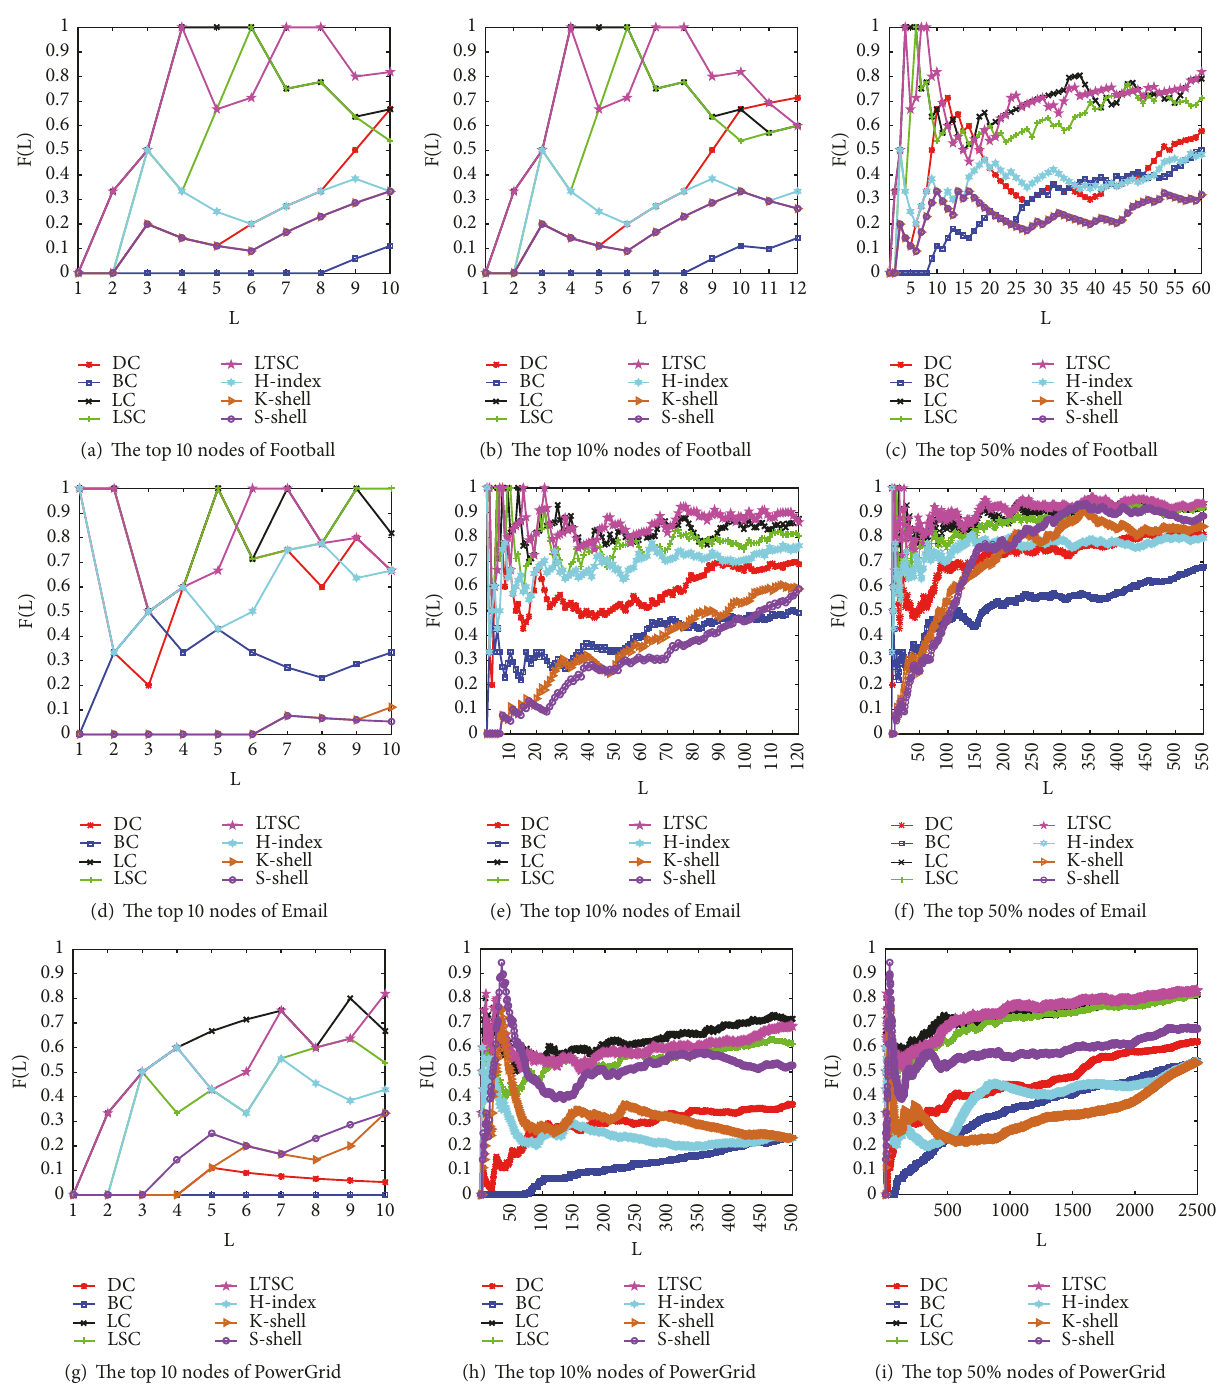
Figure 5: The ranking similarity 𝐹(𝐿) for the top 𝐿 nodes of ranks offered by eight evaluating indexes with the SIR model on Football, Email, and PowerGrid networks, respectively, where 𝐿 = 10, 10 % ,50